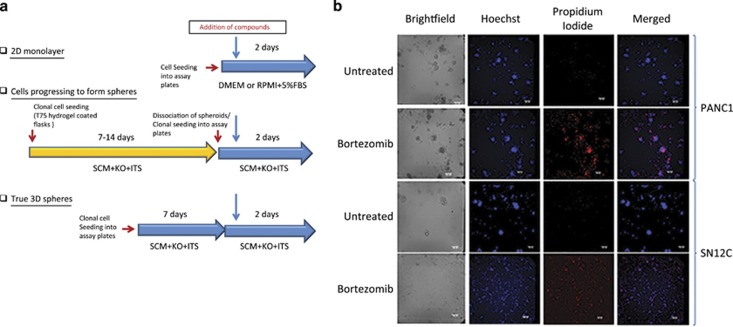
PANC1 and SN12C cell cultures in 2D monolayer, forming spheres and 3D spheres. (a) Adherent PANC1 cells were seeded in DMEM containing 10% FBS and SN12C in RPMI with 10% FBS into solid bottom white tissue culture treated 1536-well plates. Spheroid derived cells were initially cultured for 7-14 days in ULA flasks in SCM and then dissociated with Trypsin and plated into the same 1536-well assay plates as above in SCM. 3D spheres were formed by growing either PANC1 or SN12C in SCM for 7 days in the 1536-well tissue culture plates using an adhesive top seal to prevent evaporation while the spheres were forming. All three modes of cell growth were treated with the compounds for 48 h. Cell viability was quantitated using the CellTiterGloTM reagent. (b) 3D spheres of PANC1 and SN12C cells were formed in wells of a 1536-well microtiter plate seeding and incubating cells for 7 days in SCM. The morphology of the spheres was determined using brightfield and fluorescence imaging. In all, 4x images were captured of a whole well using an Incell2000 High Content Reader (GE Healthcare, Marlborough, MA, USA). Hoescht dye was used to stain all cells and PI was used to stain for dead cells